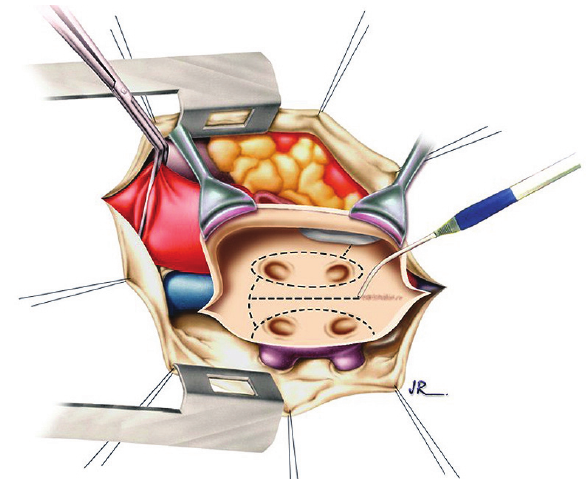
Fig. 3 - Dispositivo unipolar dotado de ponta irrigada com solução salina, usado para aplicação endocárdica da radiofreqüência, no átrio esquerdo, com a realização do isolamento das veias